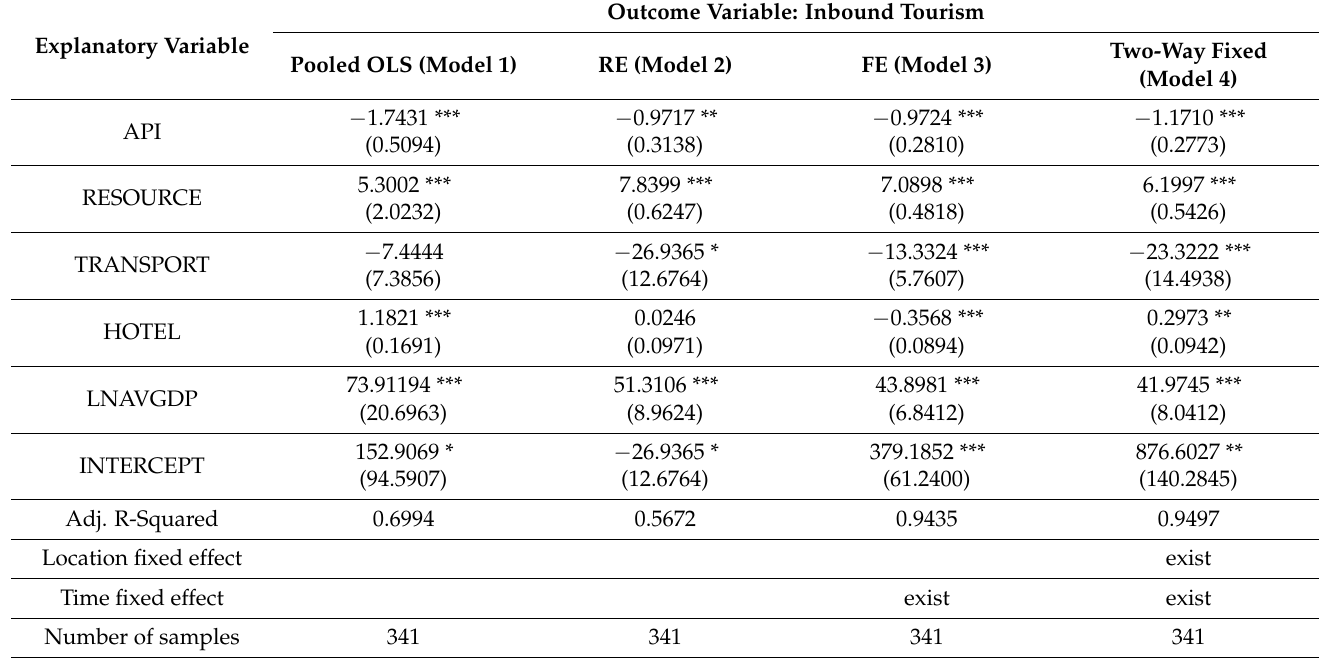
Table 2. Regression results of the impact of air pollution and control variables on inbound